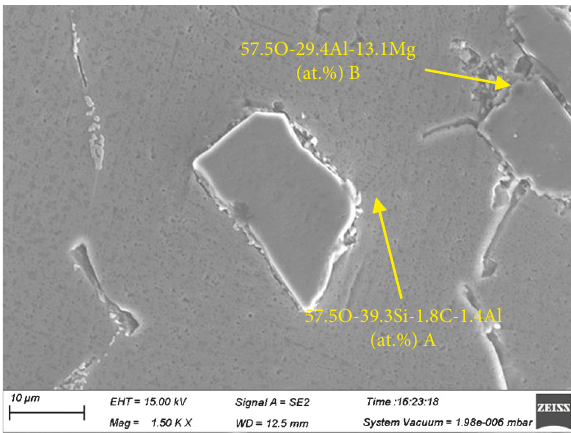
Figure 6: SEM images and EDS results of SiO MgAl 2 O 4 phase near SiC